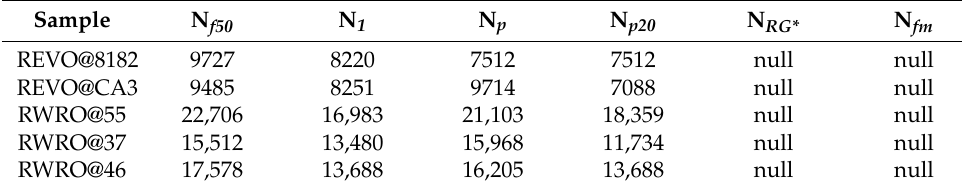
Table 8. Fatigue life of rejuvenated asphalt (5.5% strain-control).